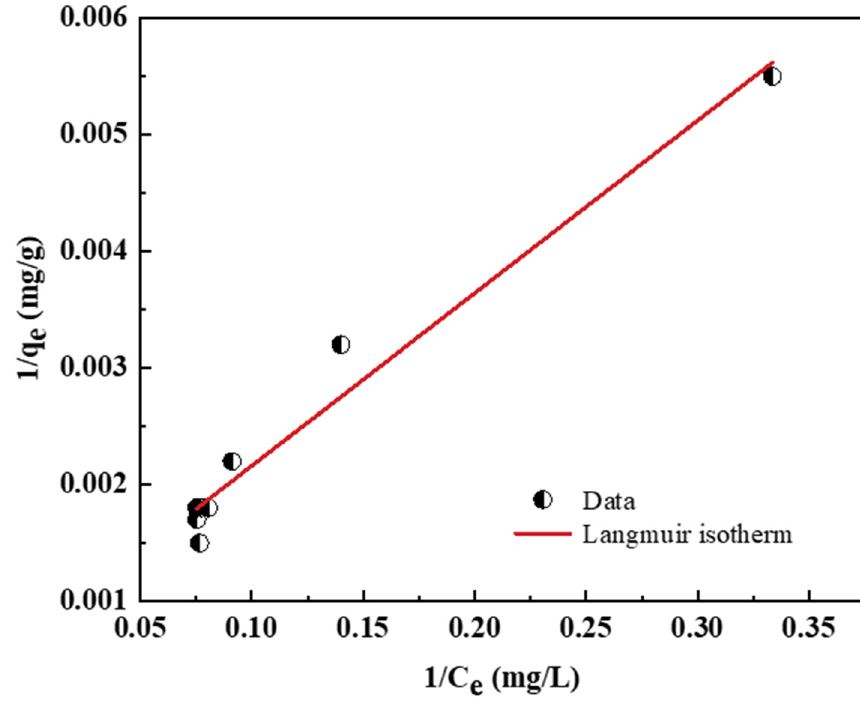
Figure 10. Isotherm data and modeling for the adsorption of HA on RGO-SiO 2 . Table 2. Langmuir and Freundlich isotherm constants for the adsorption of HA onto RGO-SiO 2 . Langmuir